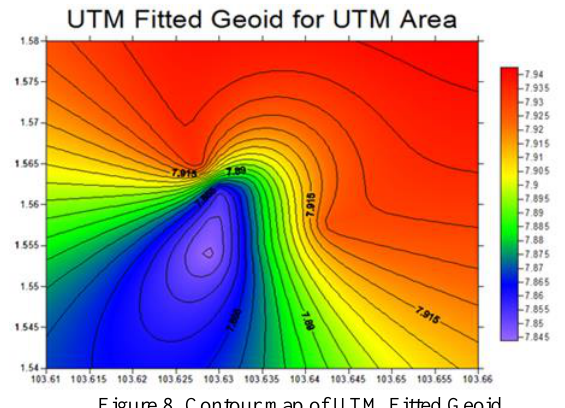
Table 7. Vertical Datum Bias at selected points